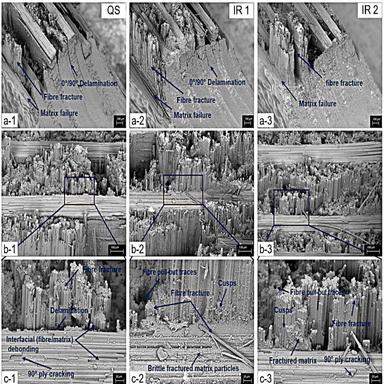
SEM fractography of DENT specimens tested at various strain rates: 1. quasi-static (QS); 2. 60 s − 1 (IR 1); and 3. 100 s − 1 (IR 2). Image locations: (a) at the initial notch tip; (b) at a 0◦/90◦ fracture surface interface; and (c) a magnification of (b).